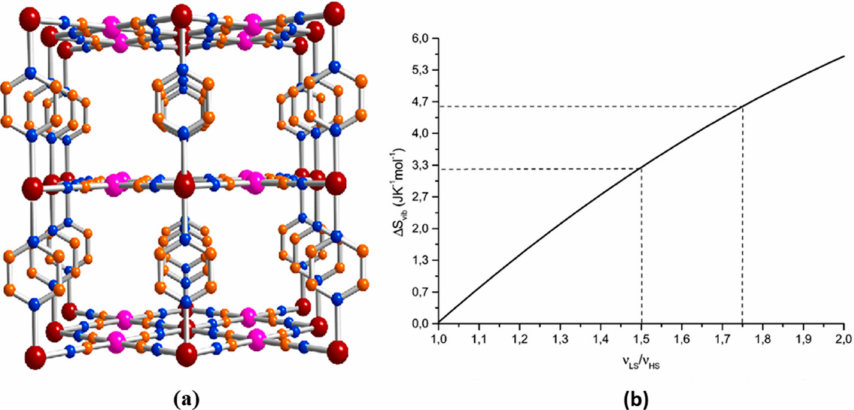
Figure 8. ( a ) General representation of the 3D structure of cyano-bridged Hofmann-type Fe(pz) [M(CN) 4 ] · 2H 2 O ( 12 ) coordination complexes. ( a ) is reprinted with permission from Inorganic Chem- change as a function of the relative frequency change occurring during the spin transition. ( b ) is reprinted with permission from ref. [44], copyright 2002, American Chemical